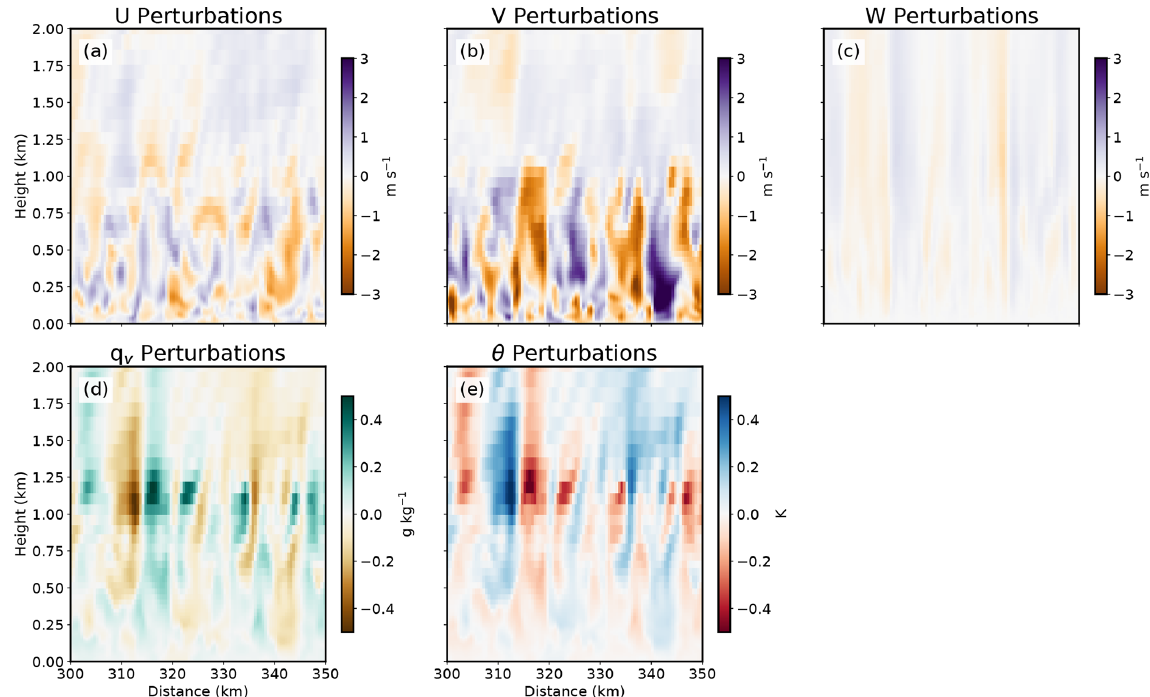
Figure 3. Vertical cross sections of boundary layer turbulent perturbations that are inserted into the nature run simulation. Plotted fields include the (a) u , (b) v , and (c) w components of wind, (d) q v , and (e) θ .